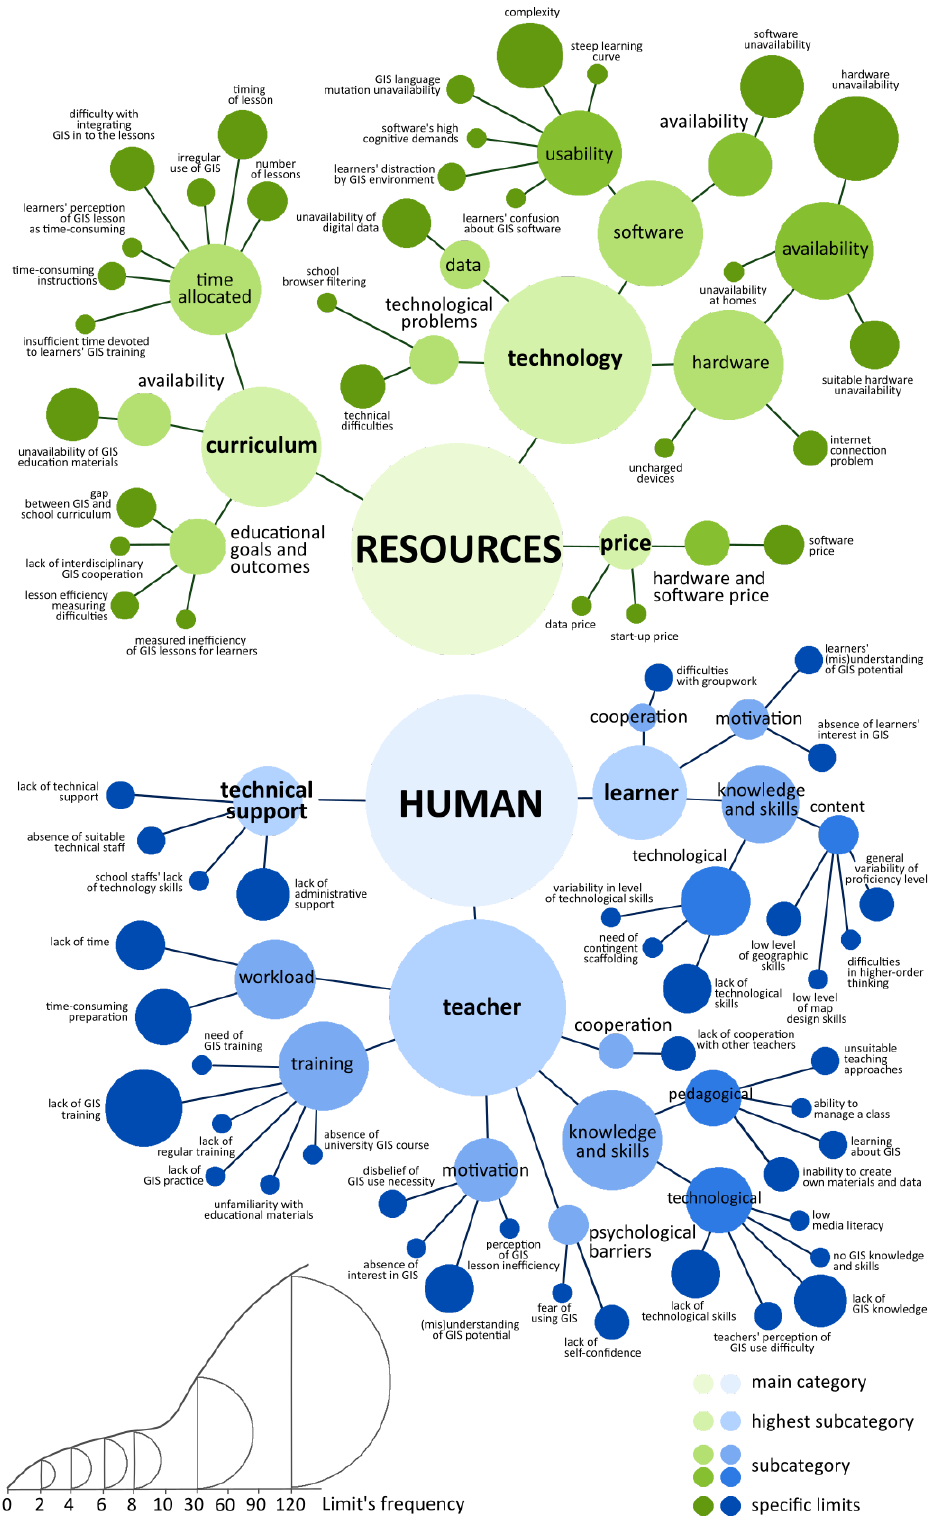
Figure 6. The identified limits of GIS implementation in lessons and their frequency.